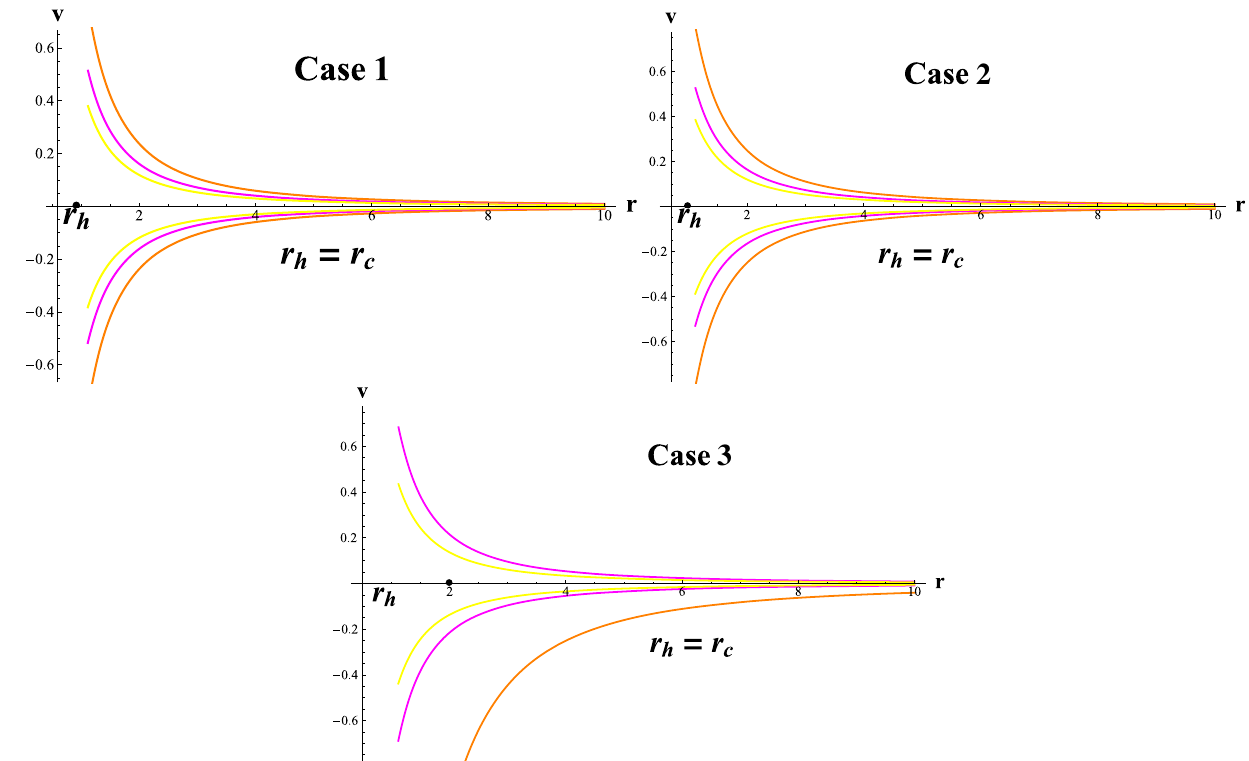
H c ≈ 1 . 001. The bottom panel (Schwarzschild BH) displays the behav- iorofEq.(36)withSchwarzschildBHparameters γ = 0, k = 0, β = 1. representation of colors for H = H c → orange, H > H c → magenta and ≈ 1 . 001, v = 1, c c